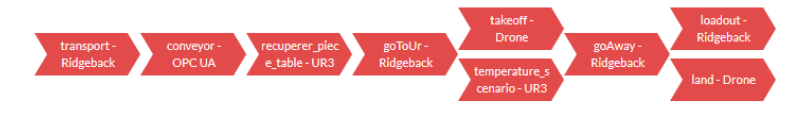
Figure 15. Demonstration scenario on